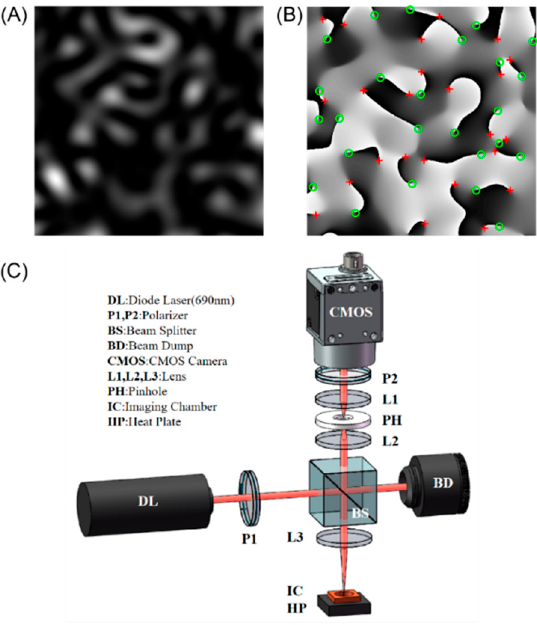
Figure 1. ( A ) The laser speckle pattern. ( B ) The pseudo-phase of the corresponding speckle pattern. The red crosses are positive optical vortices, and the green circles are negative optical vortices. ( C ) A schematic of the optical setup for acquiring dynamic speckle patterns.